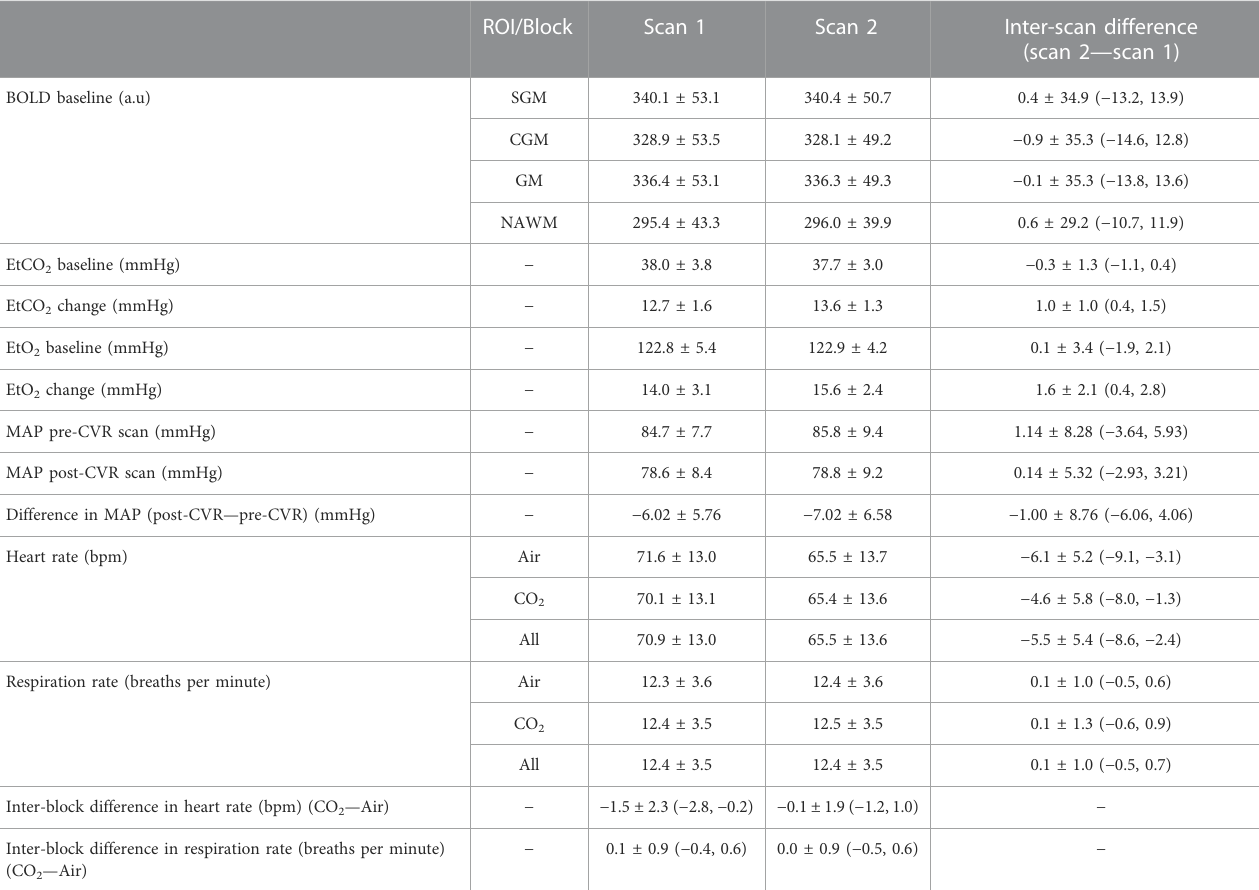
TABLE3Meanandstandarddeviation ofthephysiologicalvariables.Themeanandstandarddeviationofinter-scan andinter-blockdifferencesarereported,together with the 95% con fi dence